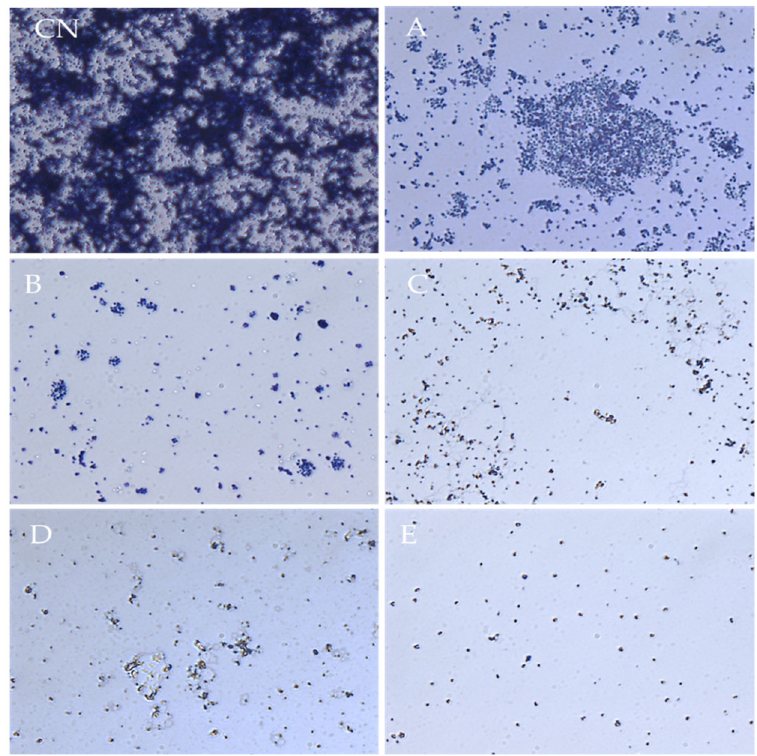
Figure 6. The 2 ‐ dimensional images of 24 h representative strain A. baumannii ATCC 19606 biofilm formed on polystyrene treated with different disinfection protocols ( A – E ). CN marks control group. The dark blue stains present the bacteria stained with crystal violet. The control was provided with A. baumannii ATCC 19606 biofilm not exposed to combined or solitary ozone gas and citric acid effects. Magnification 20×.